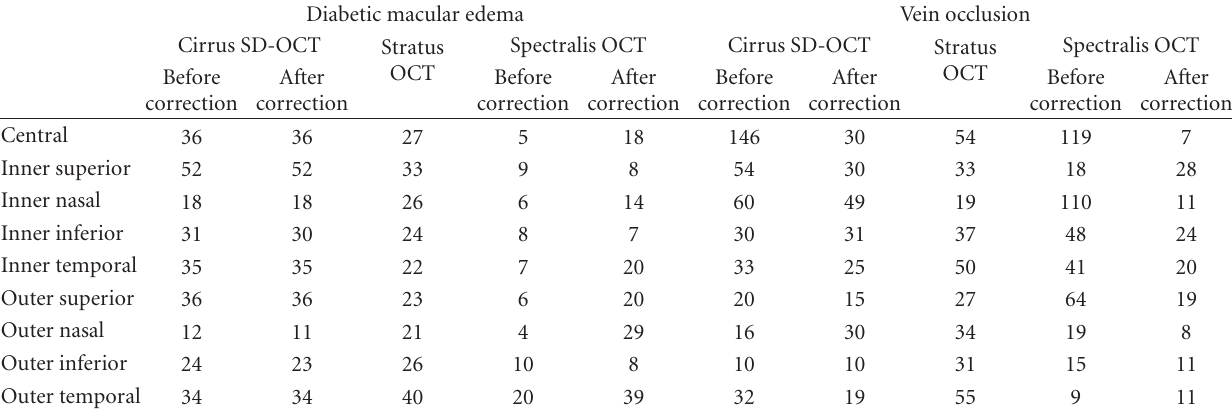
Table 4: Coe ffi cient of repeatability ( µ m) for each subfield in each OCT